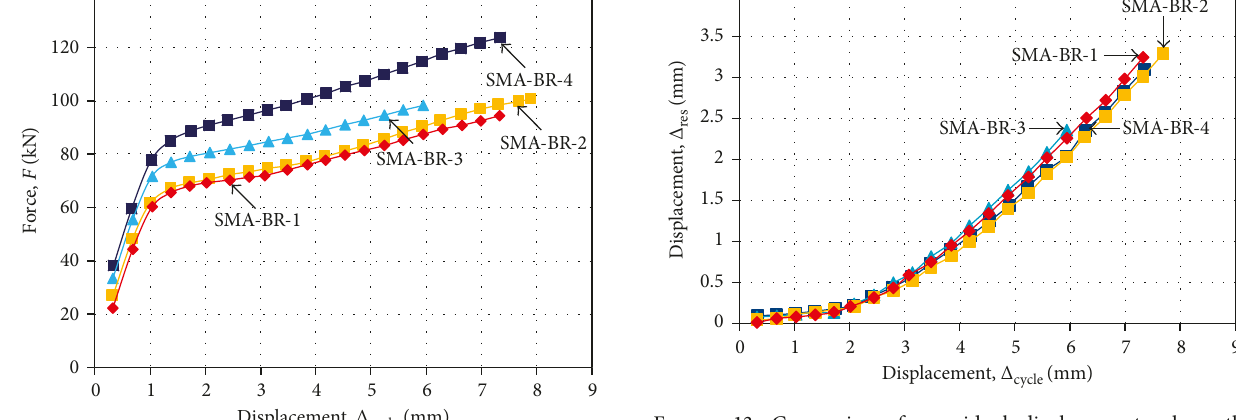
Figure 13: Comparison for residual displacements along the measurement displacement loading cycles (SMA-BR model